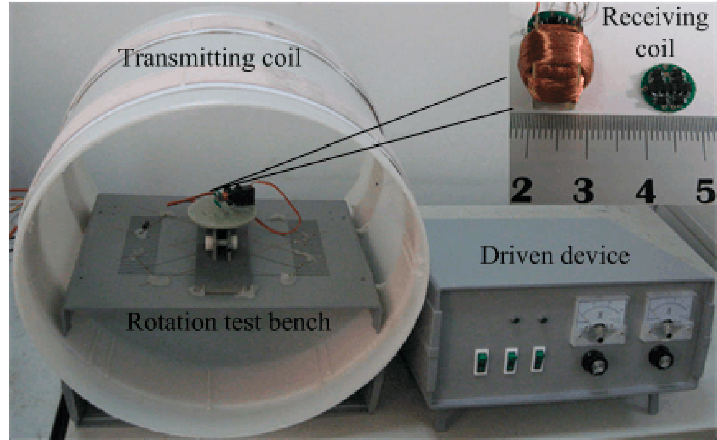
Table 1. Design parameters of the 3D receiving coil.